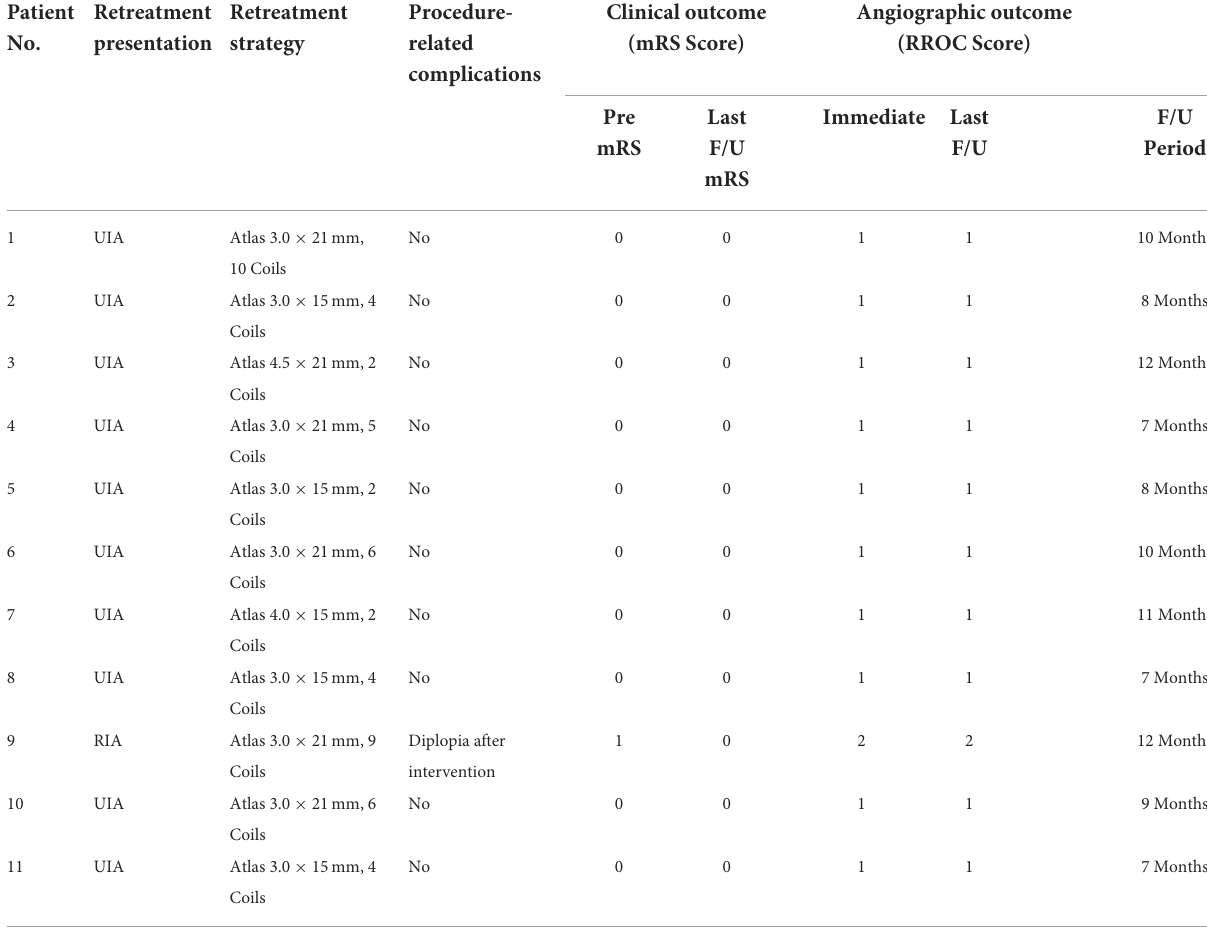
TABLE 2 Characteristics of recurrent aneurysms, procedural details of stent-assisted coiling, and follow-up outcomes. Patient Retreatment Retreatment Procedure- No. presentation strategy